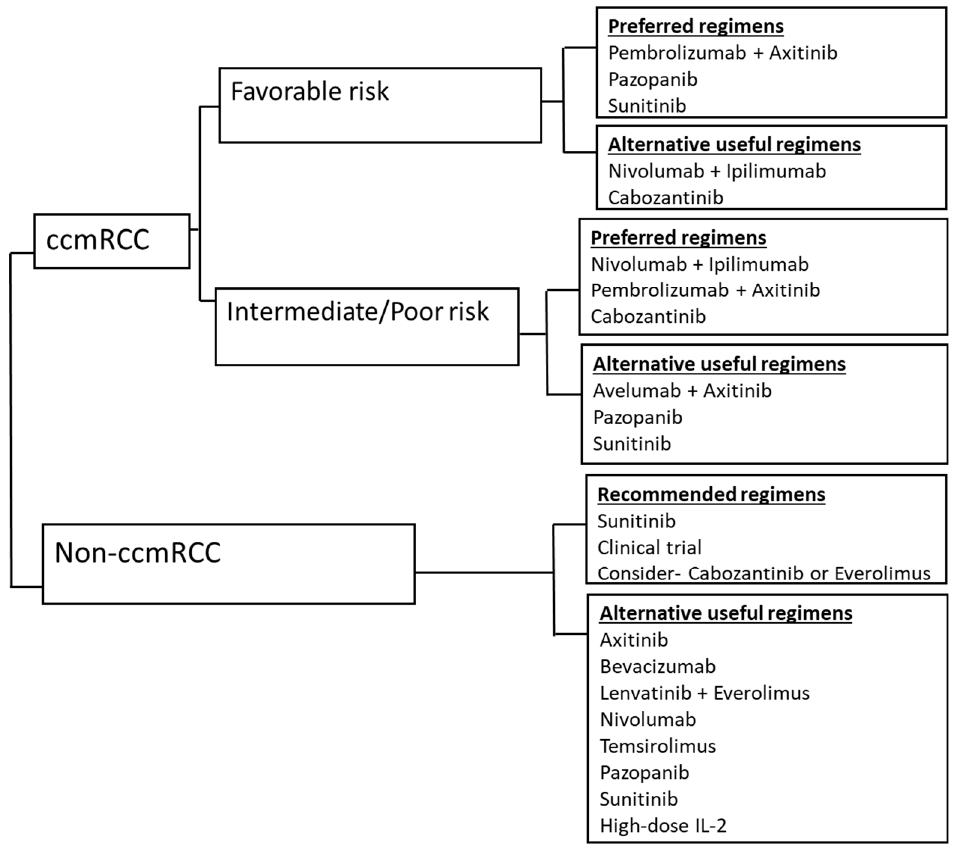
Figure 1. Overview of treatment strategy for treatment naïve metastatic RCC, based on IMDC risk-stratification. ccmRCC, clear cell metastatic renal cell carcinoma; non-ccmRCC, non-clear cell metastatic renal cell carcinoma; risk stratification based on International Metastatic Renal Cell Carcinoma Database Consortium (IMDC) criteria. The International Metastatic RCC Database Consortium (IMDC) prognostic model integrates six adverse factors: Karnofsky performance status (KPS) <80 percent, time from diagnosis to treatment < 1-year, hemoglobin concentration < lower limit of normal, serum calcium > upper limit of normal, neutrophil count > upper limit of normal, platelet count > upper limit of normal. (Favorable risk: no risk factors, intermediate risk: 1 or 2 risk factors, poor risk: 3 or more risk factors).